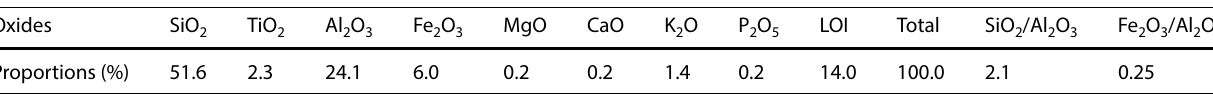
Table 2 Geochemical composition of alluvial clays Oxides